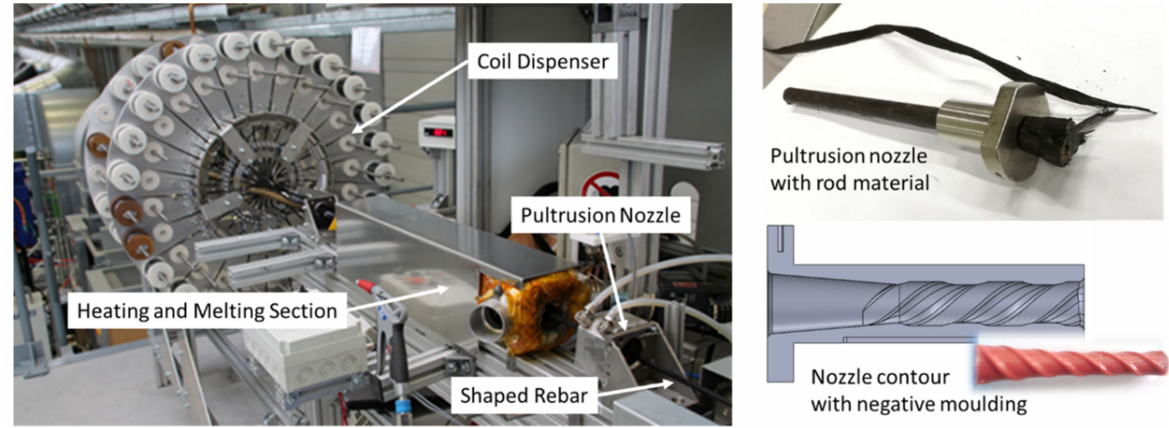
Figure 3. Helix-pultrusion and design of the nozzle geometry for profiling.